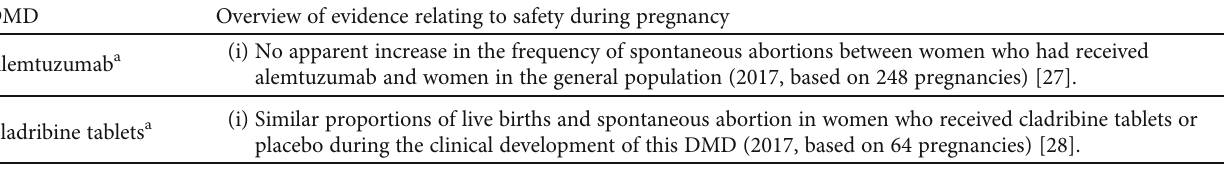
Table 2: Summary of evidence relating to the foetal safety of DMDs used for relapsing-remitting multiple sclerosis. DMD Overview of evidence relating to safety during pregnancy Alemtuzumab a